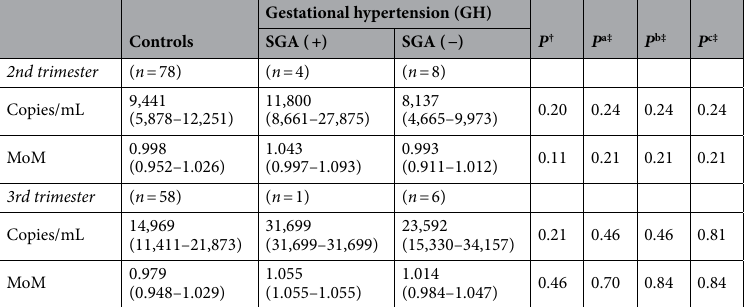
Table 5. Comparison of methylated HYP2 levels and MoM values between controls and patients with gestational hypertension with or without SGA neonates. Data are given as median (interquartile range). P a , GH with SGA versus controls; P b , GH without SGA versus controls; P c , GH with SGA versus GH without SGA. MoM multiple of the median, SGA small for gestational age. † P value by the Kruskal–Wallis test. ‡ P value by the Wilcoxon rank sum test (adjusted by the step-up Bonferroni method).